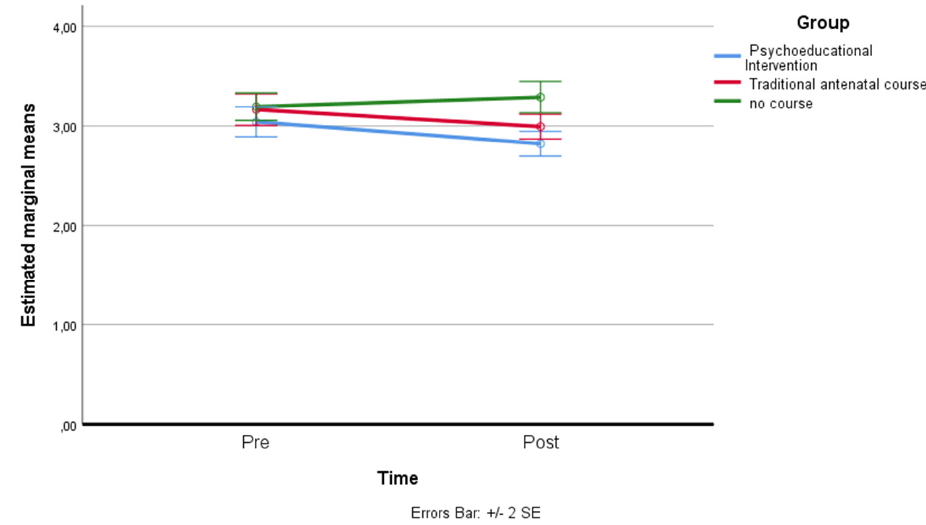
Figure 6. Estimated marginal means of perceived need for sharing.